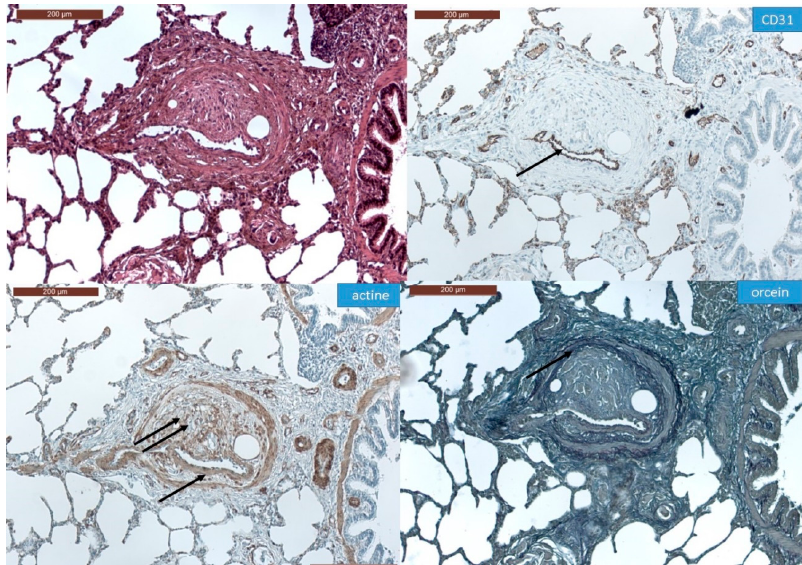
Figure 6. Immunohistochemistry of Stage II angiophagy in the large animal model of CTEPH (axial cut). The hematein–eosin–saffron coloration (left upper panel) shows a cellularized embolic specimen in the pulmonary artery wall. The embolic specimen is covered by endothelial cells (arrow, CD31 staining, right upper panel). The smooth muscle cell layer of the media is disrupted at the contact of the embolic specimen (double arrow, actin staining, left lower panel), whereas it remains intact on the opposite side of the pulmonary artery (single arrow, left lower panel). The fuchsin–resorcin (orcein) staining (right lower panel) shows an intact elastic lamina (arrow).